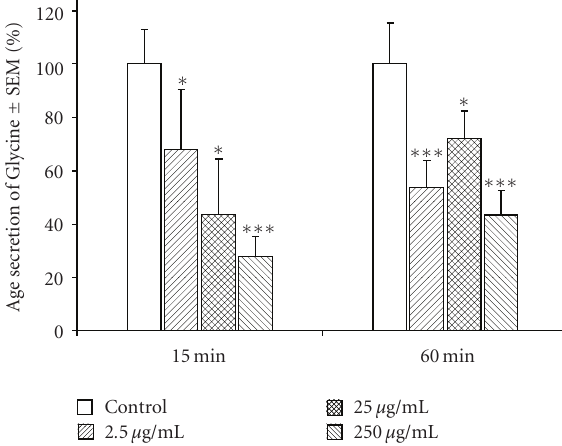
Figure 3: E ff ect produced by di ff erent concentrations (2.5, 25, and 250 μ g/mL) of methanolic extract of Nigella sativa on Glycine release from cortical neurons. The cells were stimulated for 15 and 60minutes with each concentration. The values are expressed as a percentage of secretion with respect to basal value ( 100%). Statistical significances were calculated with respect to the corresponding control at its respective time points: ∗ P < . 05 and ∗∗∗ P < . 001.